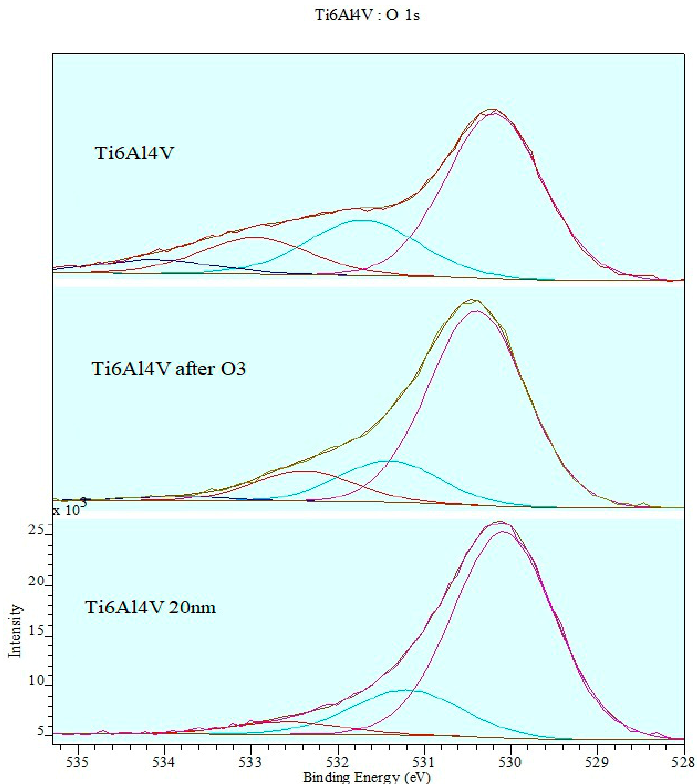
Figure 10. Deconvolution of XPS spectrum of O1s band.